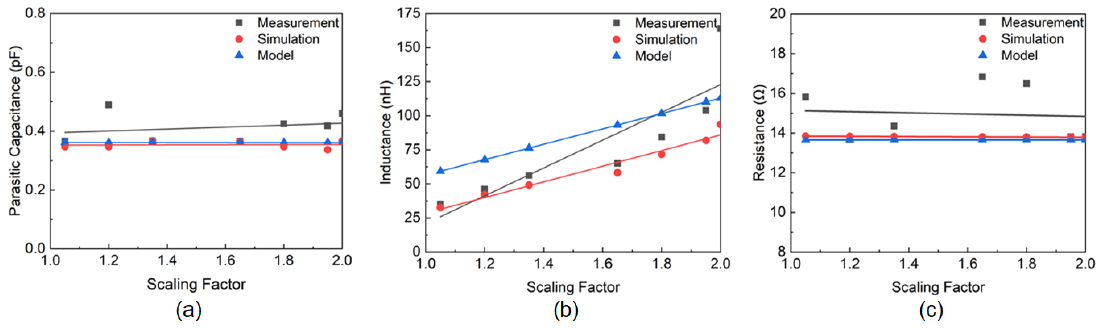
Figure 6. ( a ) Parasitic capacitance at self-resonant frequency with respect to the scaling factor, m . ( b ) Inductance with respect to the scaling factor, m . ( c ) Resistance with respect to the scaling factor, m